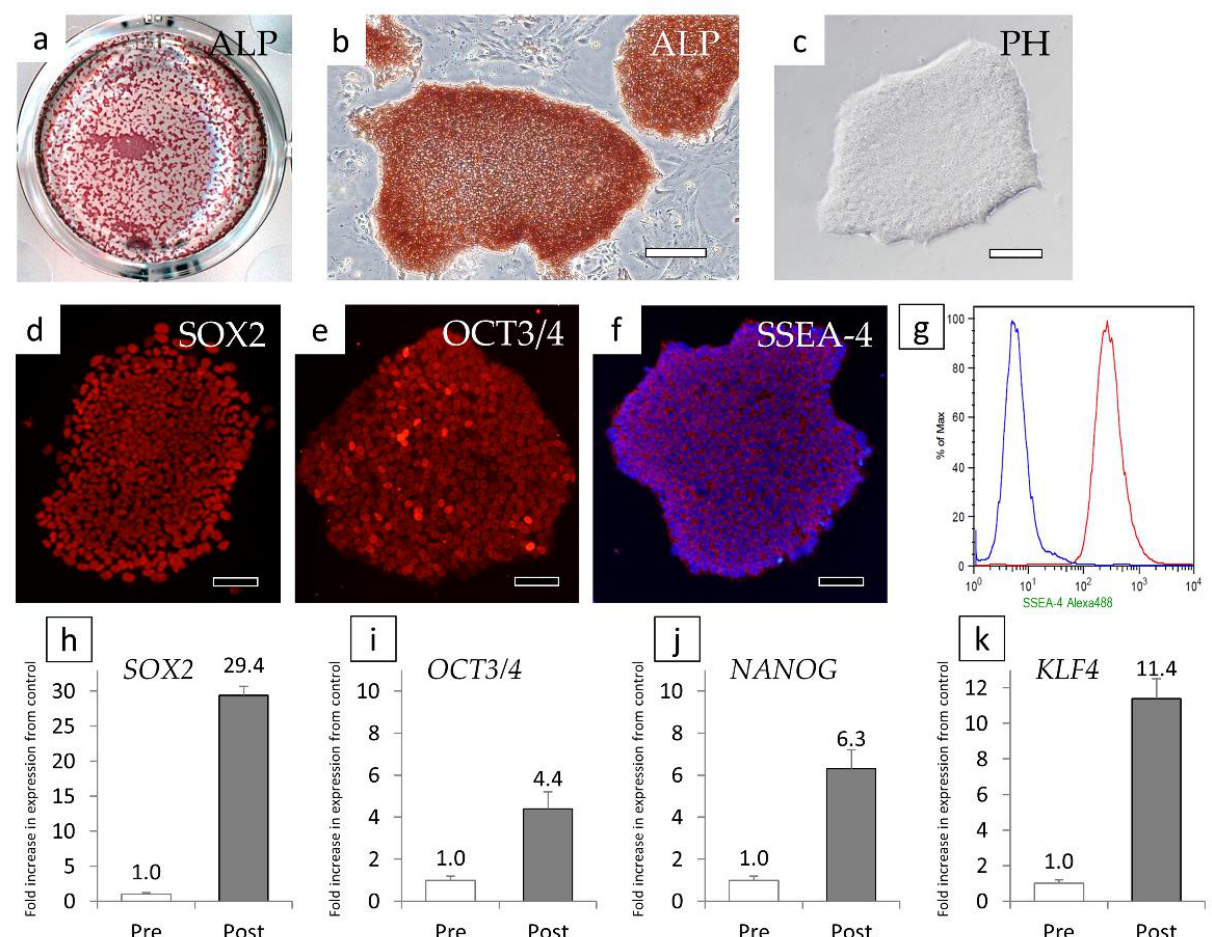
Figure 3. Verification of H-iris iPS cells. ( a ) Low magnification of an ALP-stained multiplate. ( b ) ALP staining of aggregated cell colonies. ( c ) The morphology of cloned colonies observed with a phase contrast microscope. ( a – f ) Fluorescent immunostaining of cloned colonies for ( d ) SOX2, ( e ) OCT3/4, and ( f ) SSEA-4. ( g ) Analysis of SSEA-4 by FCM. The blue line represents the histogram of negative cells. ( h – k ) Relative semi-quantitative analysis of gene expression of ( h ) SOX2 , ( i ) OCT3/4 , ( j ) NANOG , and ( k ) KLF4 . Pre: iris tissue stem/progenitor cells before gene transfer, Post: cells of cloned colonies (Post). Bars: 100 μm.